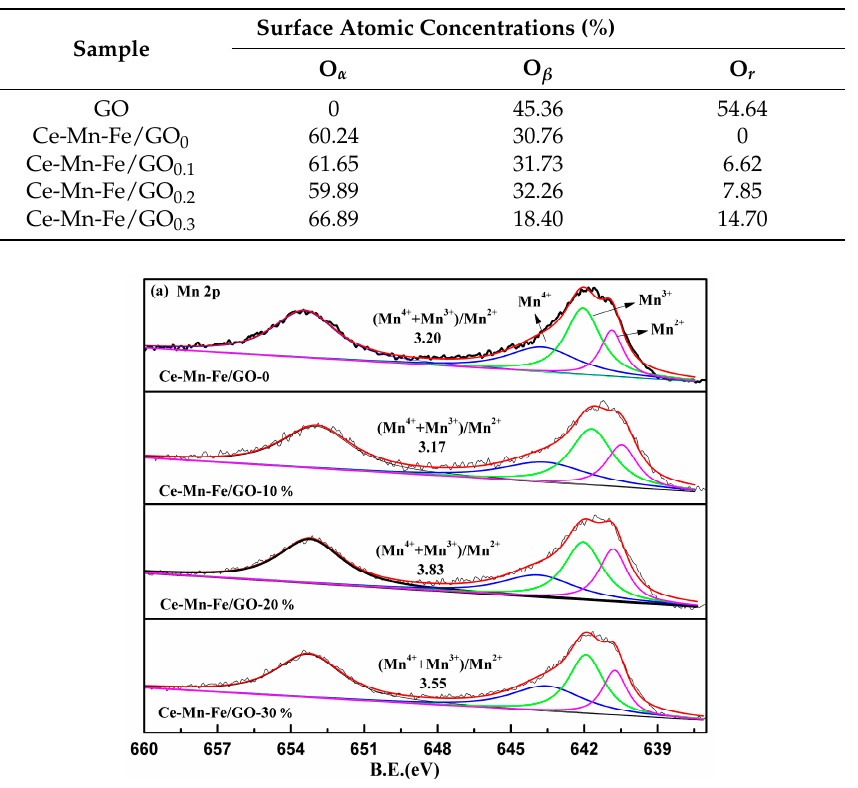
Table 2. The concentrations of different types of oxygen (O α , O β , O r ) in graphene oxide (GO) and